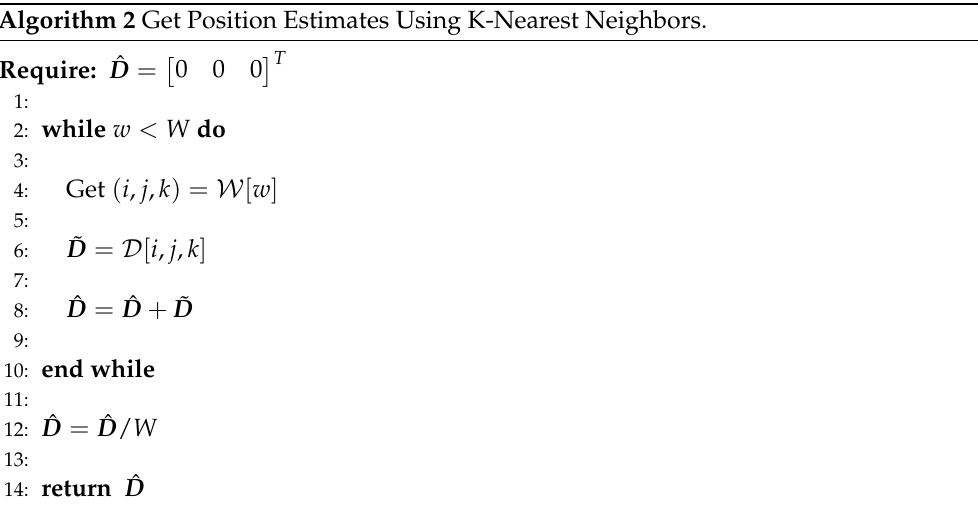
Algorithm 2 Get Position Estimates Using K-Nearest